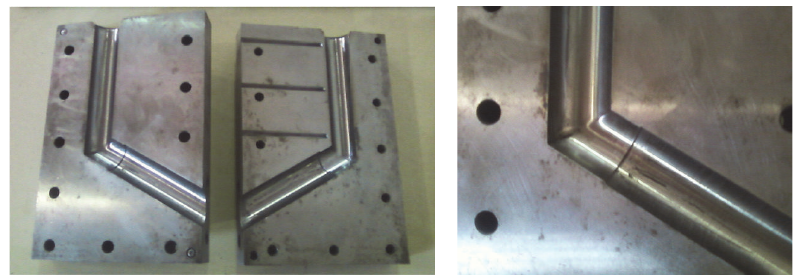
Figure 1: Details of the used ECAP die.